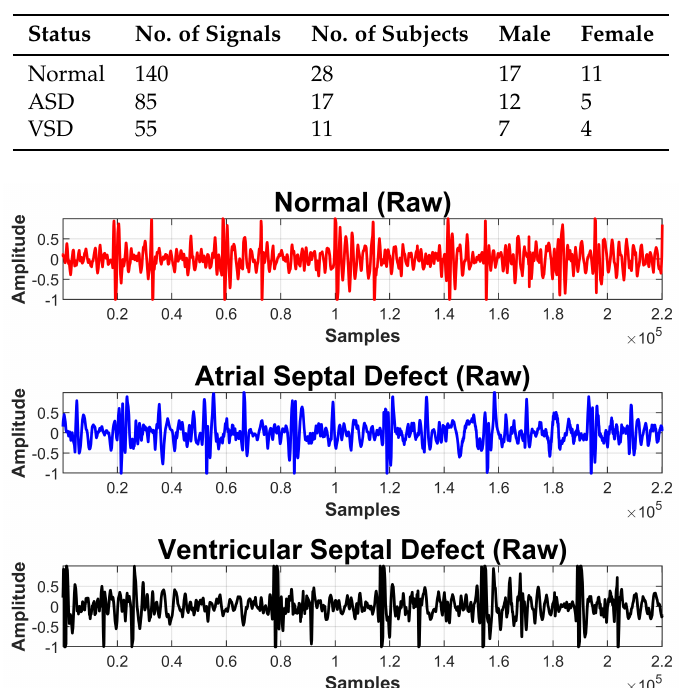
Figure 2. PCG signals collected from normal, arterial septal defect (ASD), and ventricular septal defect (VSD)